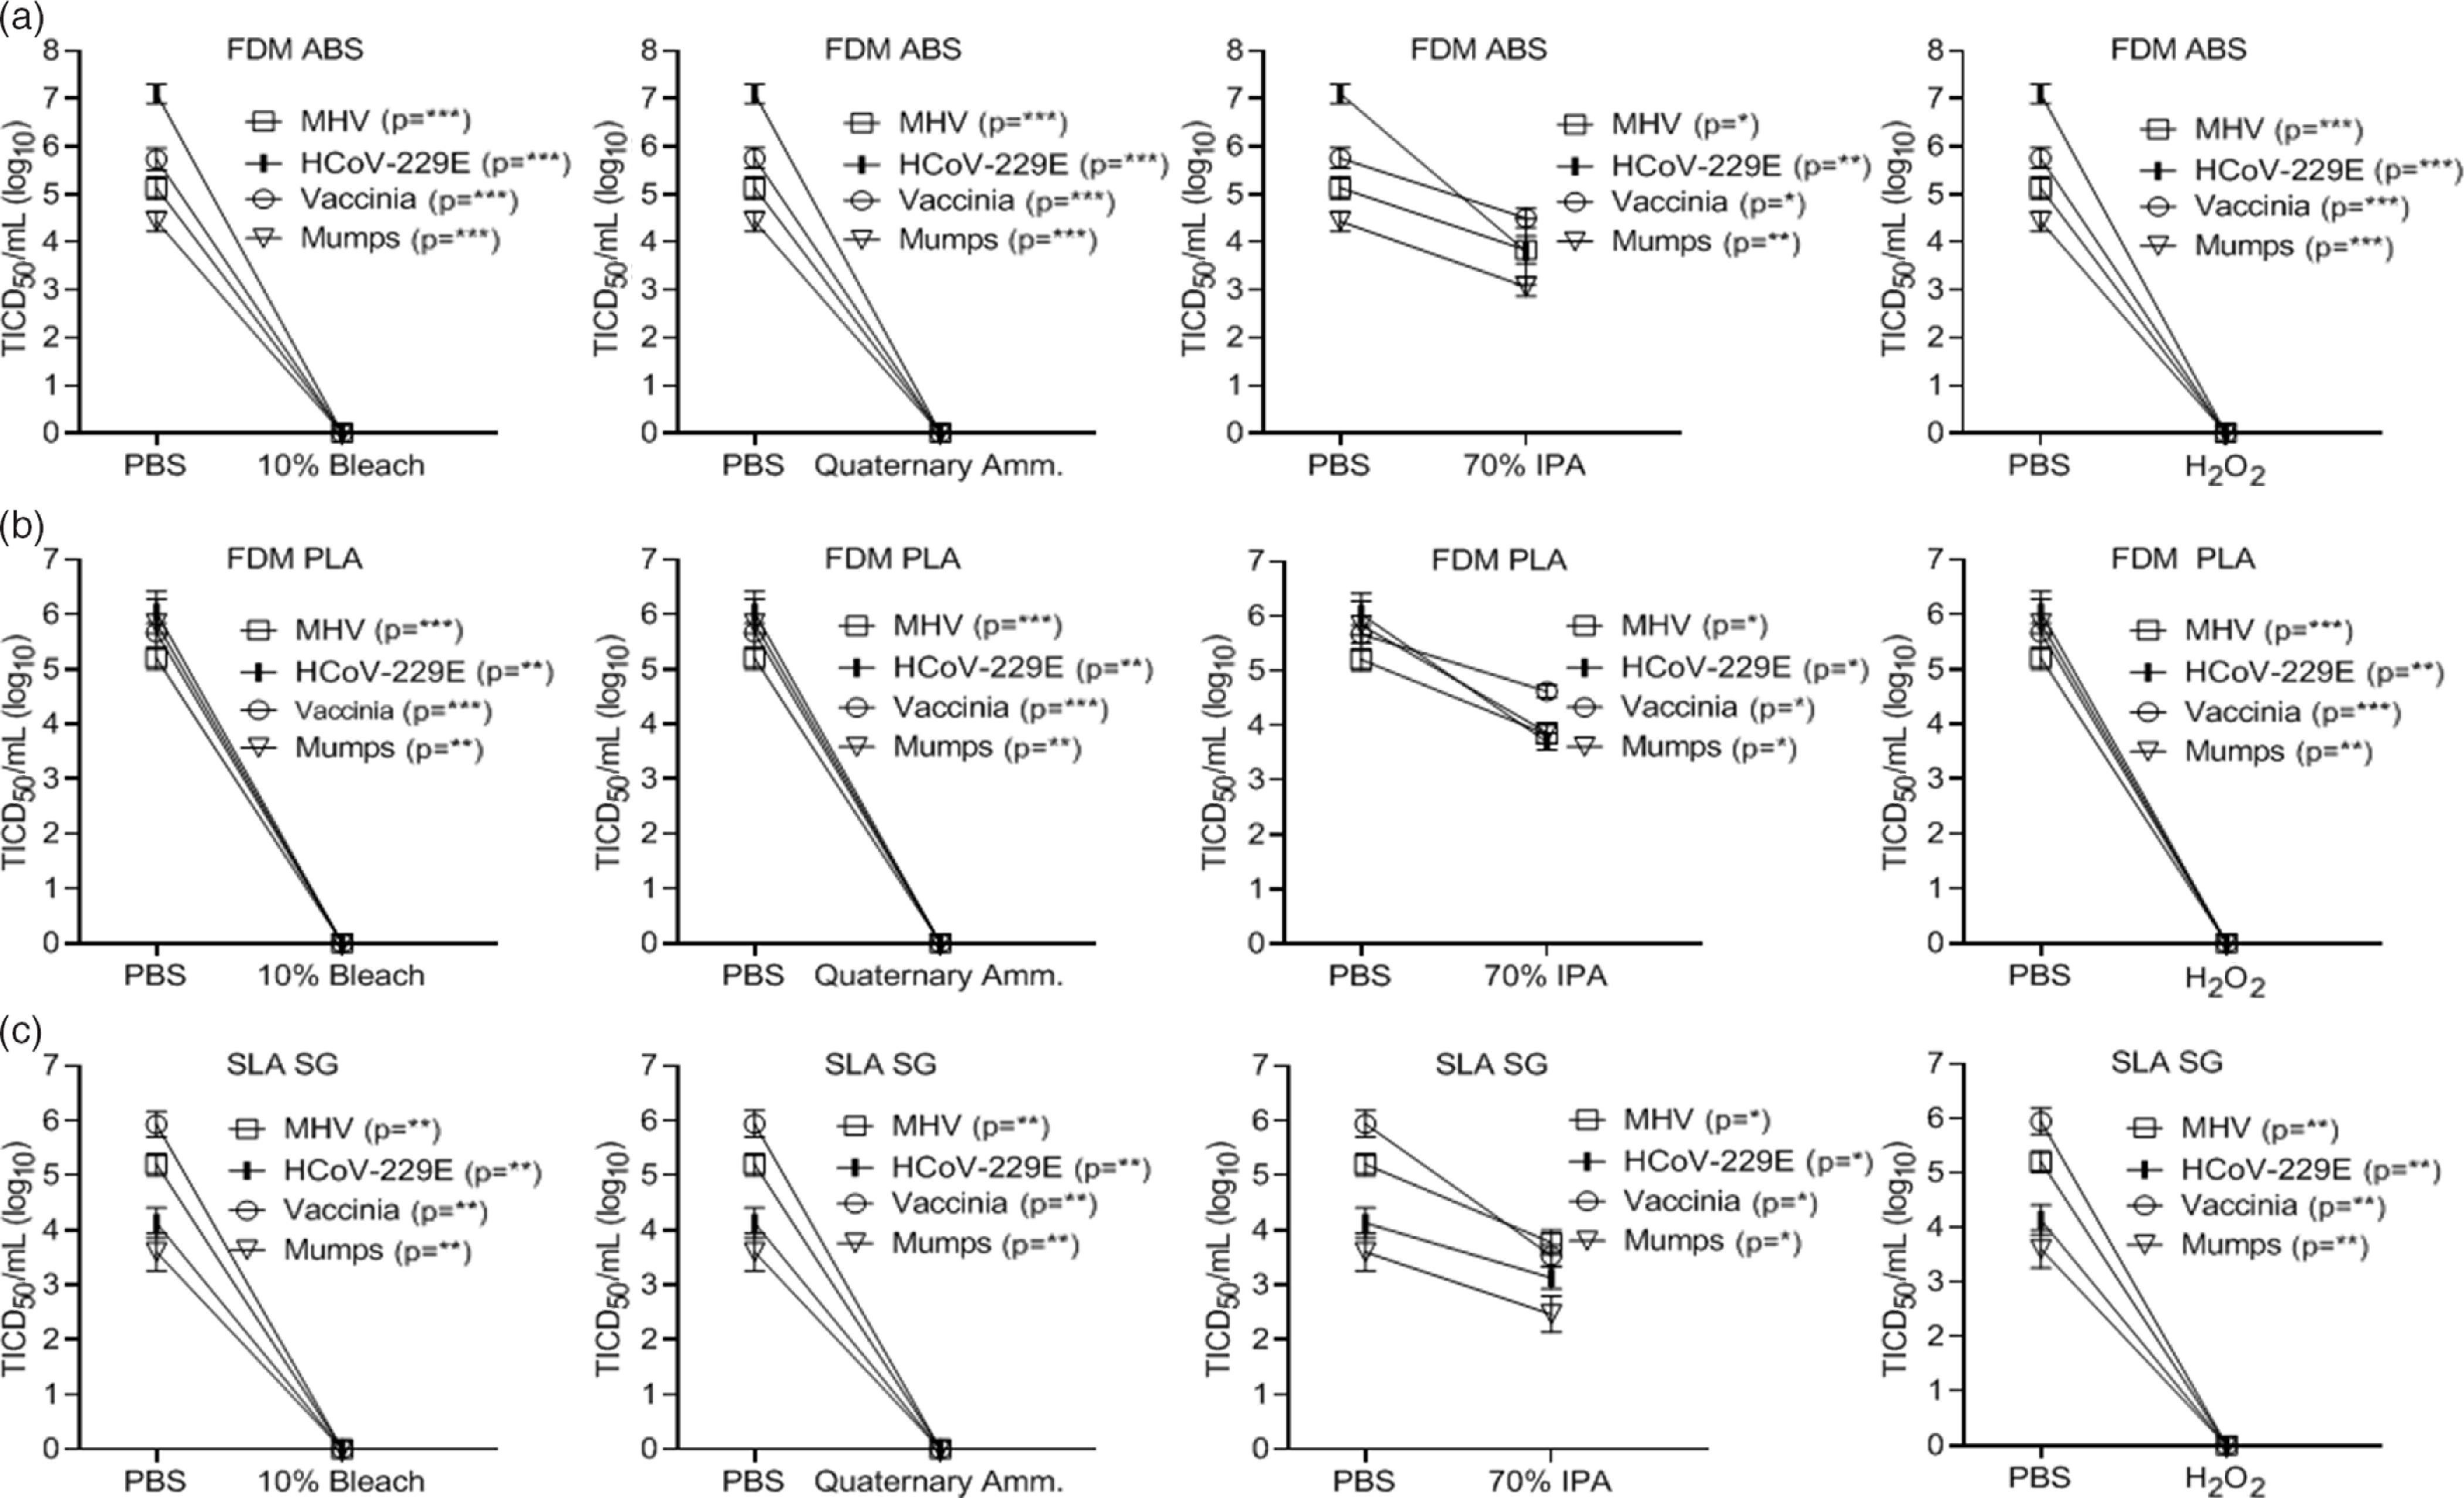
Chemical inactivation of viruses (log10) on alternative 3D-printed mask materials by type of disinfectant versus controls. Virus recovery from alternative 3D-printed mask material (A) FDM acrylonitrile butadiene styrene (FDM ABS), (B) FDM polylactic acid (PLA), and (C) stereolithography acrylic-surgical guide (SLA SG) after exposure to a single-wipe application of 10% bleach, ammonium quaternary, 70% IPA, and 3% H2O2. Wipe application of PBS acted as the control. Virus titer was completed as described in the Methods section in the cell type indicated in Table 1. Significance was determined using the Student t test. *P < .05; **P< .01; ***P < .001; ****P < .0001; ns, not significant. Error bars represent standard error of the mean (SEM) of triplicate experiments.